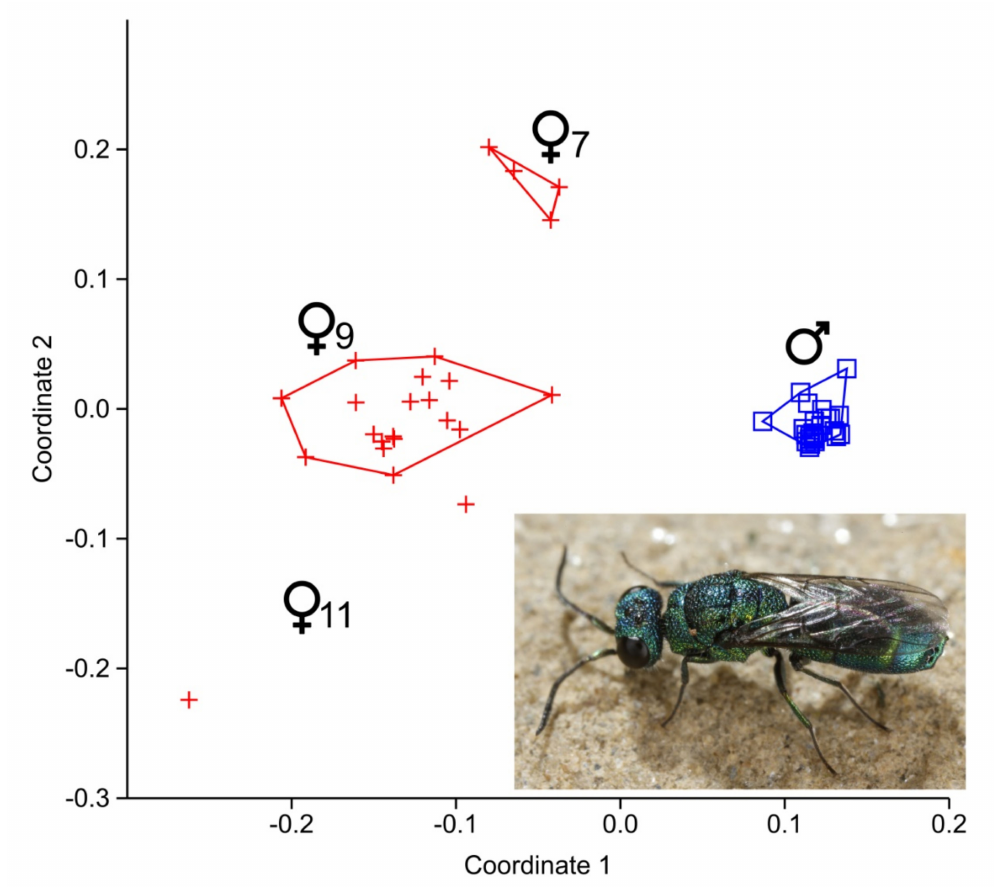
Figure 1. Non-metric multidimensional scaling (NMDS) based on Bray-Curtis distances of all individual cuticular hydrocarbon (CHC) profiles of Trichrysis cyanea . Males are indicated by blue squares, females by red crosses. Note the distinct female clusters (also see dendrogram in Figure S2). The different female clusters are named after the position of double-bonds of the main CHCs. The photo shows a living individual of T. cyanea . Photo: Gernot